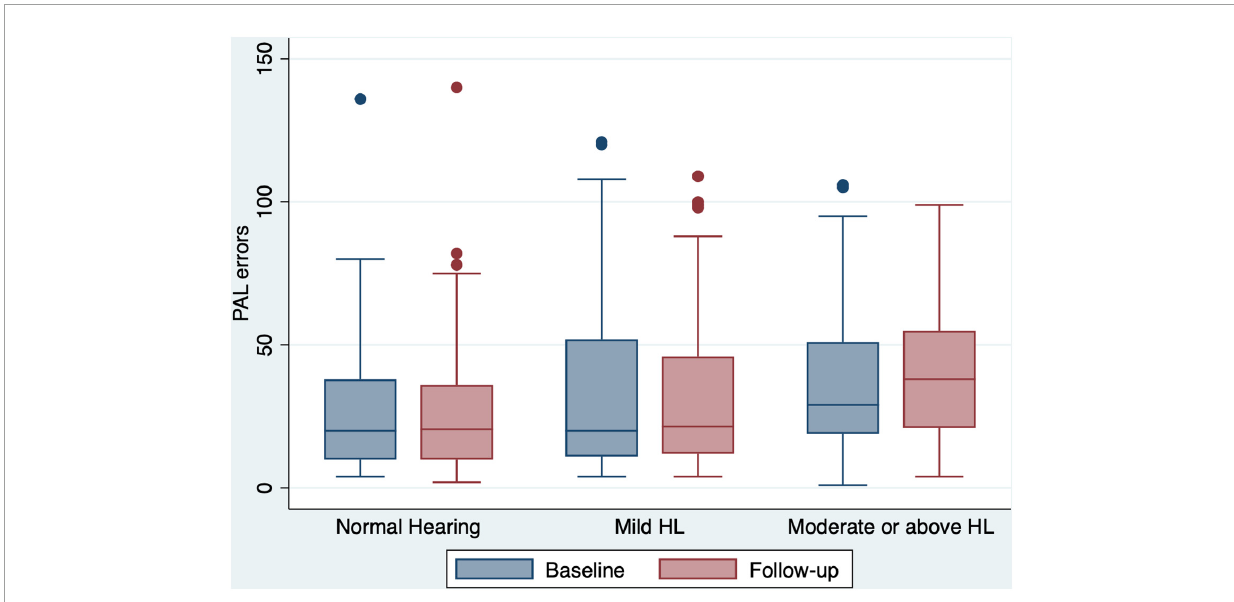
FIGURE3 Box and whisker plot of PAL errors and quartiles at baseline and follow-up, according to the HL categories. Any outlier at baseline/follow-up is shown by a dot. PAL, paired associates learning; HL, hearing loss.